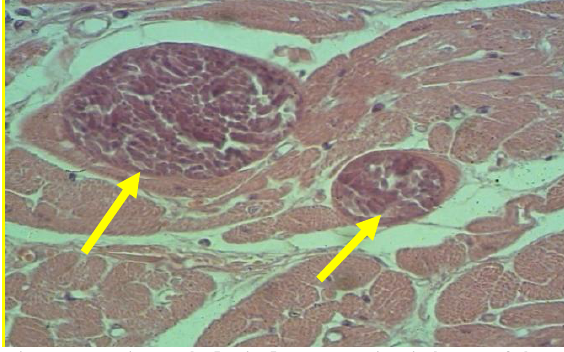
Figure, 1: Histopathological cross section in heart of sheep infected by chronic Toxoplasma gondii shows multiple variable size of parasite cyst ( ) scatter in the cardiac muscle tissue without inflammatory cells response. (H and EX400 ).